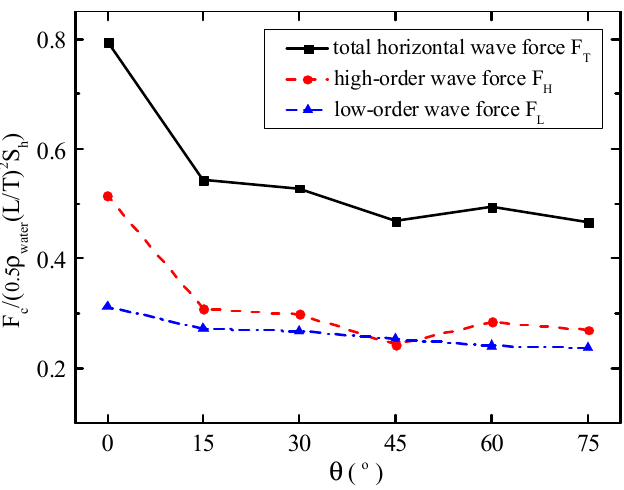
Figure 14. Comparison of the maximum normalized wave forces with transverse inclined angles θ . Table 3. The peak value of wave forces in di ff erent transverse inclined angles.